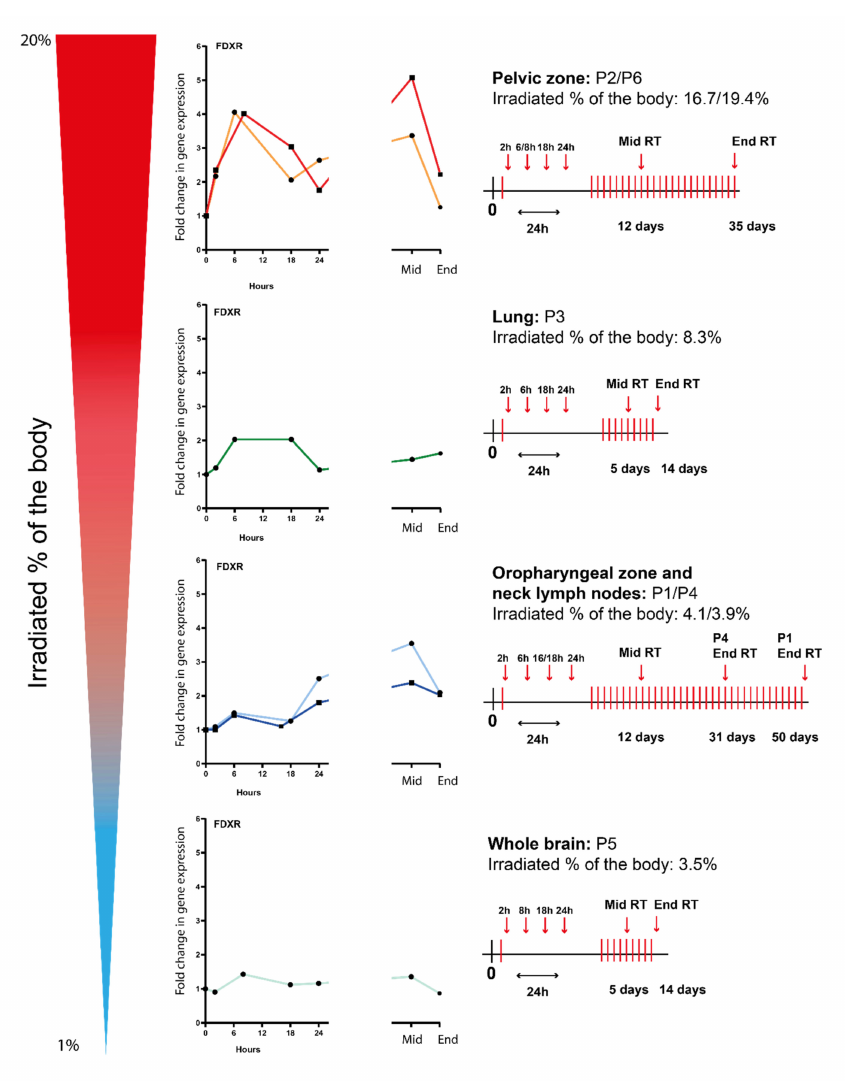
Figure 2. FDXR expression profiles of several types of radiotherapy cancer patients (i.e., lung, neck, brain, and pelvis) ranked by irradiated % of the body at 2 h, 6–8 h, 16–18 h, and 24 h after the first fraction and at the middle and end of radiotherapy. A schematic radiotherapy schedule has been included for each irradiated